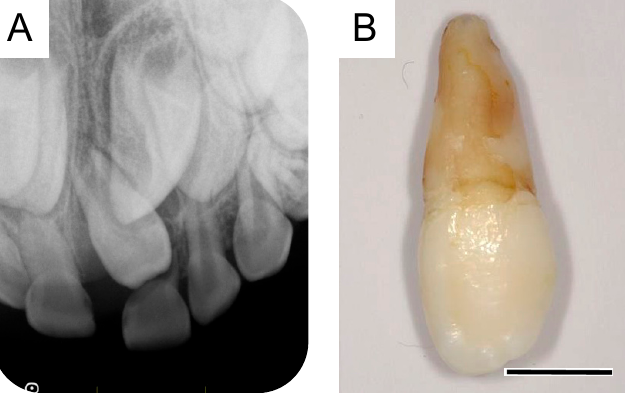
Figure 1. Extraction of the first supernumerary tooth. ( A ) Periapical radiograph of the first supernumerary tooth detected at the age of 5 years and 5 months. ( B ) Extracted first supernumerary tooth at the age of 5 years and 11 months. Scale bar: 5 mm.